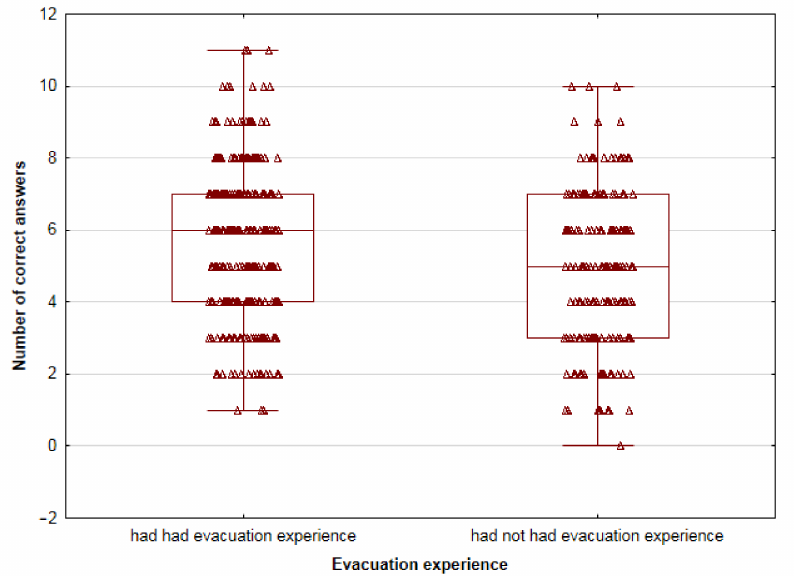
Figure 7. Knowledge of road tunnel safety procedures among the respondents who had evacuation experience and those who had no such